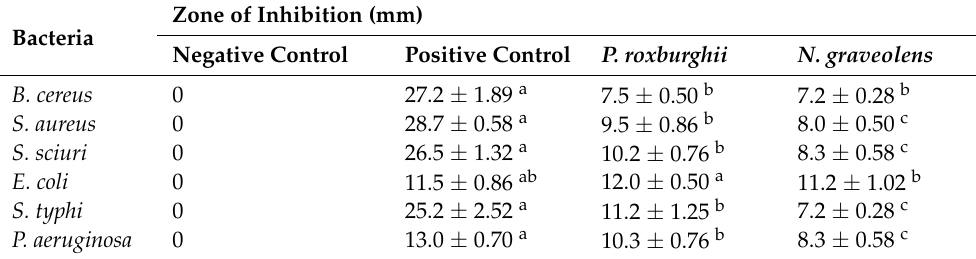
Antibacterial activity of P. roxburghii and N. graveolens extracts against foodborne pathogenic